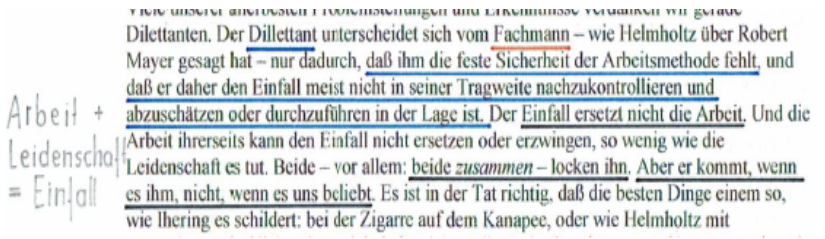
Figure 4. Annotation of intralingually inferred word meaning (Reprinted from Weber 1930, p. 13).